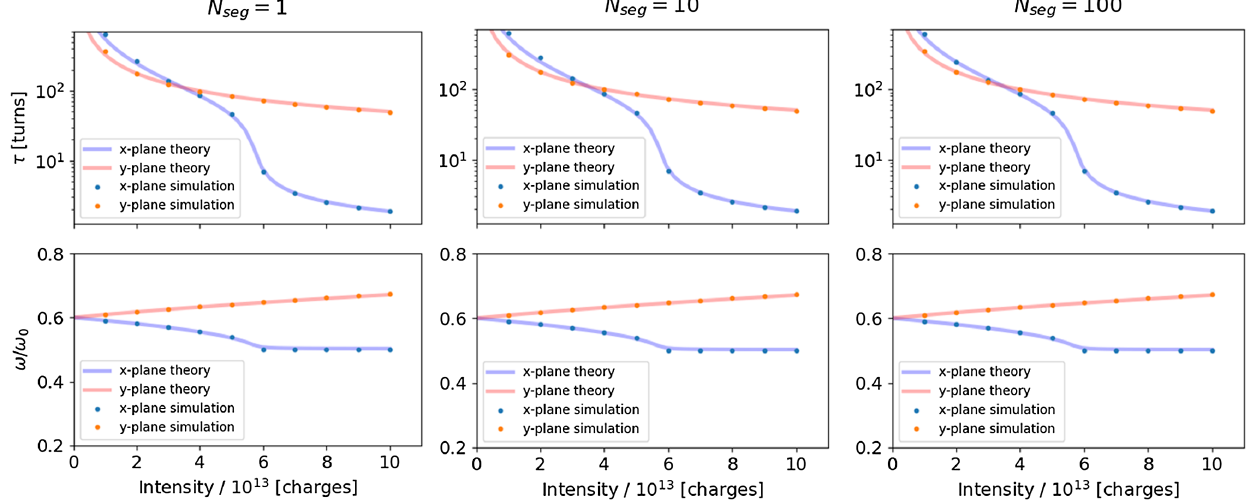
FIG. 1. Same figure as Fig. 6 of [2], using a logarithmic scale for the vertical axis of the instability rise times, and dividing the lattice in 1, 10 and 100 segments ( N ). py HEADTAIL simulations (with dots) are compared to theory accounting for coupling between two waves seg (with full lines) for the horizontal (blue) and the vertical (red) planes. The rise time, at the top, and the normalized frequency shift, at the bottom, are shown. No effect of the lattice segmentation is